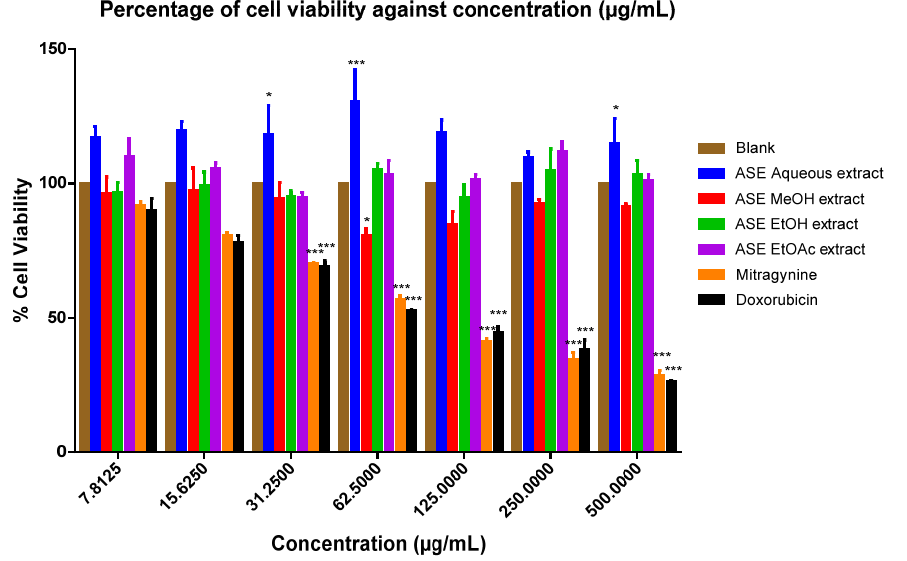
Figure 1. Percentage viability of human embryonic kidney cells against various concentrations of treatment with mitragynine, doxorubicin, and M. speciosa ASE leaf extracts. Data shown as mean ± SEM ( n = 6). * p < 0.05, *** p < 0.001 compared with DMSO as blank (one-way ANOVA, followed by Dunnett’s test).